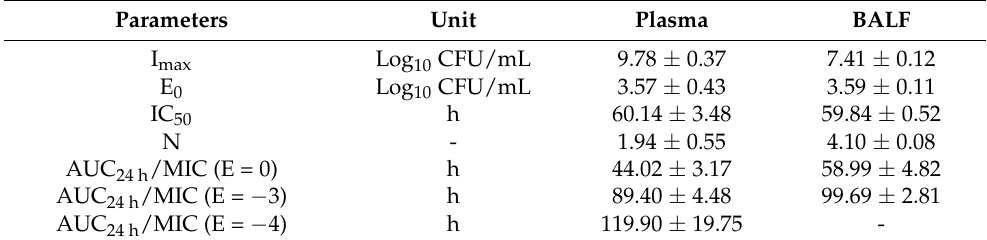
Table 3. Integration PK/PD model of CEF against P. multacia in plasma of infected pigs.